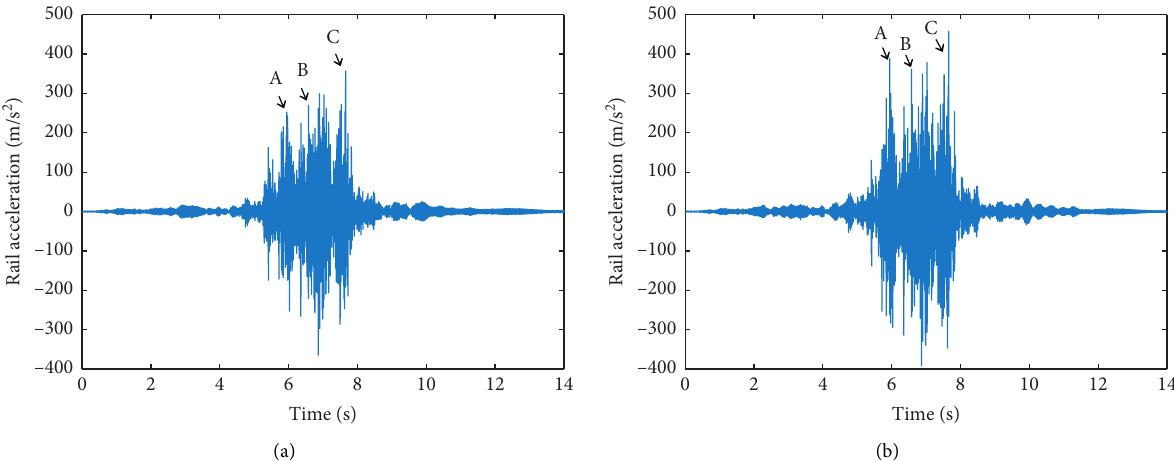
Figure 8: Effect of tunnel differential settlement on the vertical acceleration at the midpoint of the rail. (a) Without differential settlement. (b) With differential